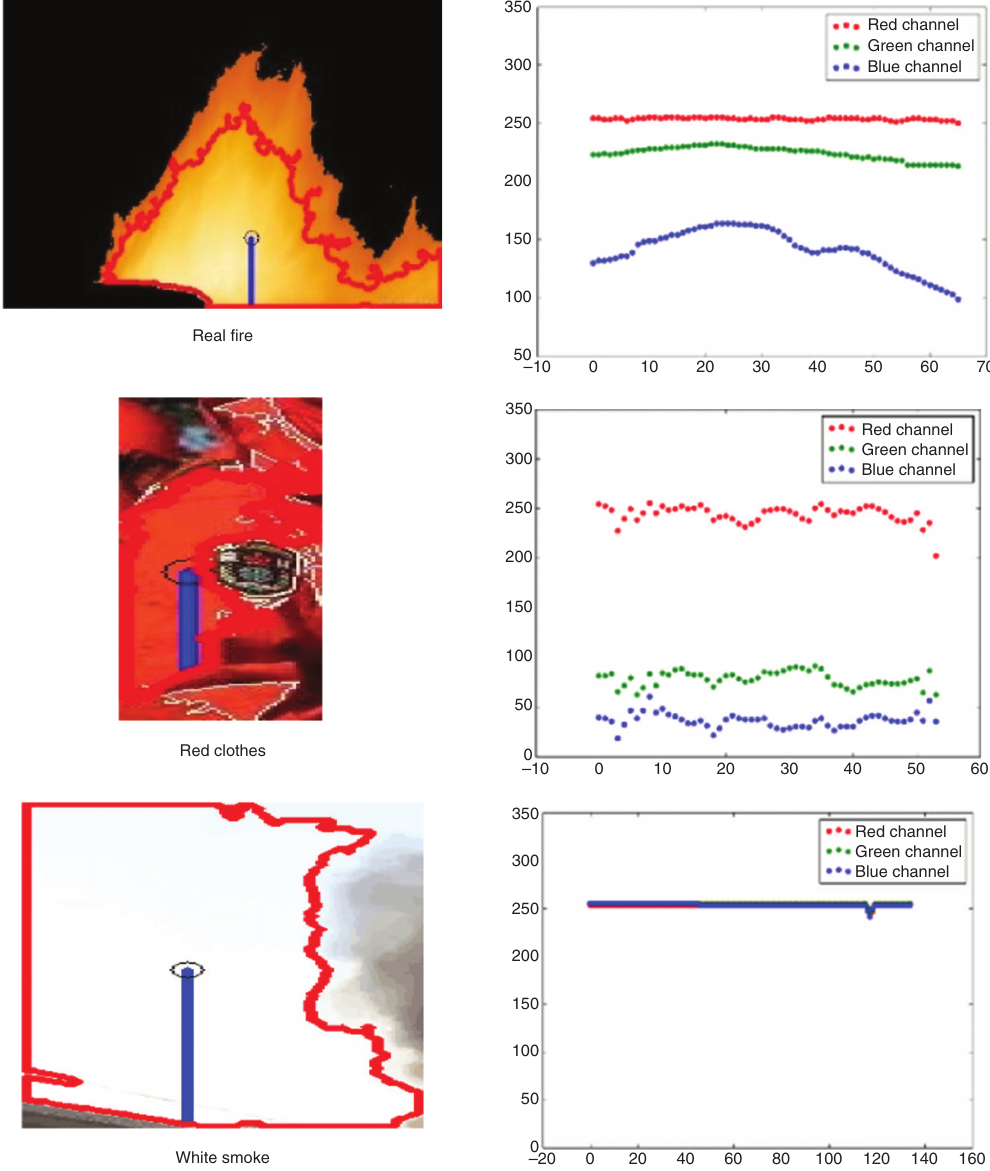
Figure 8: Changing Rate of the Pixel Value for Flame and Non-flame